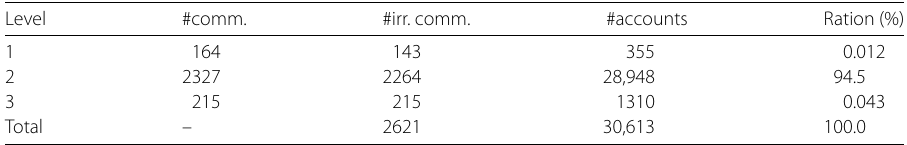
Table 3 Numbers of communities, irreducible communities, and accounts at each level of community analysis using Infomap Level #comm. #irr. comm. #accounts Ration